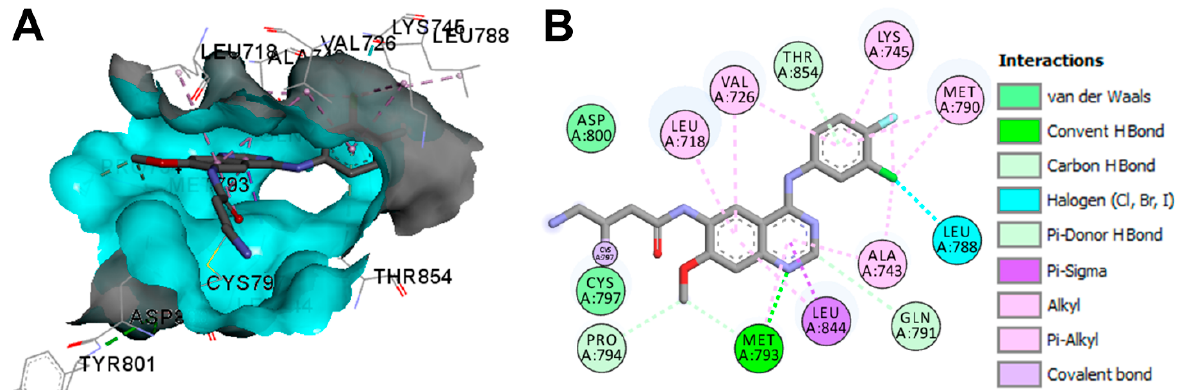
Figure 23. Binding modes of dacomitinib (shown as sticks) into T790M EGFR kinase domain (pdb: 4I24): ( A ) 3D binding mode, receptor shown as hydrogen bond surface; ( B ) 2D binding mode showing different types of binding interactions; the figure was generated using Discovery Studio Visualizer (V16.1.0.15350).